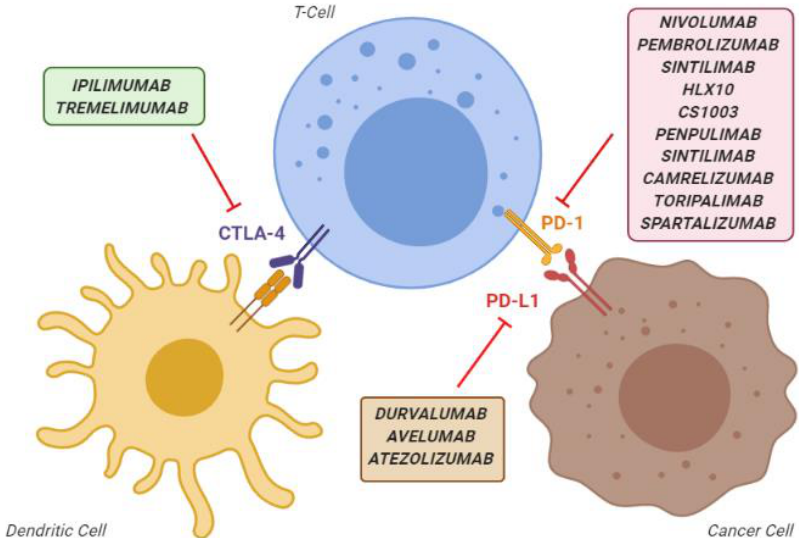
Figure 1. Overview of the main immune checkpoint inhibitors, classified according to their mechanism of action. CTLA-4, cytotoxic T-lymphocyte-associated protein 4; PD-1, programmed death-1 protein; PD-L1, programmed death-ligand 1.